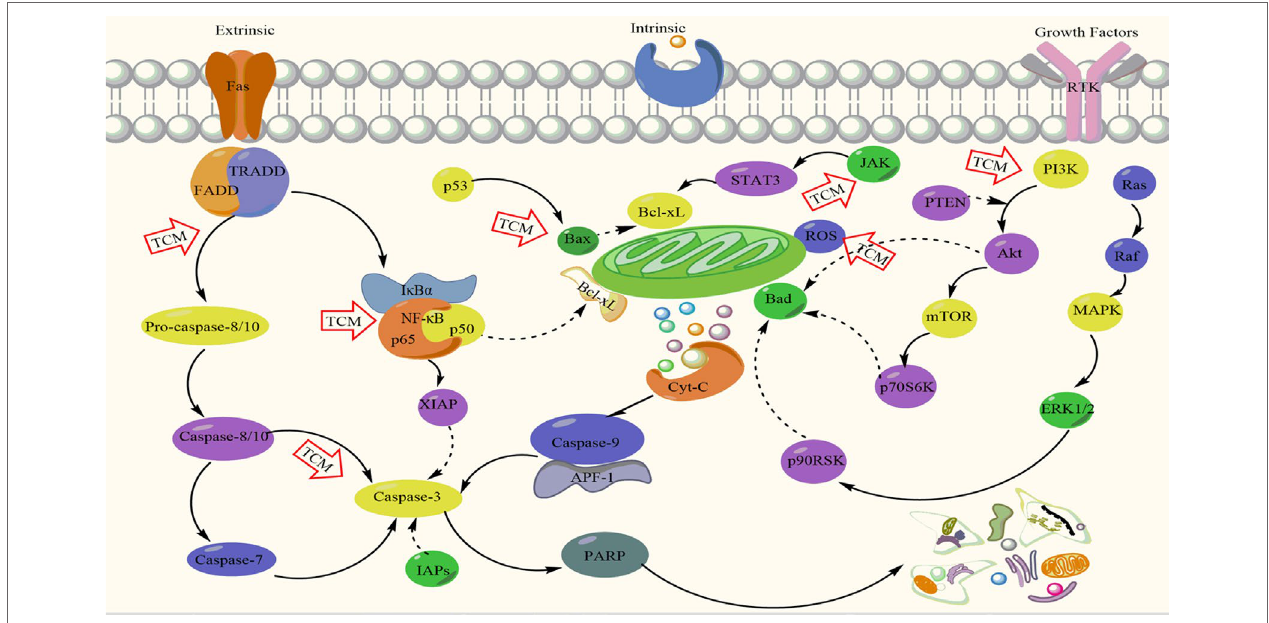
FIGURE 1 | Mechanistic actions of apoptosis induction by traditional Chinese medicines (TCMs). Akt, protein kinase B; APF-1, ATP-dependent proteolysis factor 1; Bax, BCL2-associated X; Bcl, B cell lymphoma; Cyt c, cytochrome c; ERK1/2, extracellular regulated protein kinases; FADD, Fas associated death domain; IAPs, inhibitor of apoptosis proteins; I κ B α , nuclear factor of kappa light polypeptide gene enhancer in B-cells inhibitor, alpha. JAK, Janus kinase; MAPK, mitogen-activated protein kinase; Mcl, myeloid cell leukemia sequence 1; mTOR, mammalian target of rapamycin; NF- κ B, nuclear factor kappa B; PI3K, phosphatidylinositol-3 kinase; PARP, poly ADP-ribose polymerase; PTEN, phosphate and tension homology deleted on chromosome ten; Raf, rapidly accelerated fibrosarcoma; ROS, reactive oxygen species; RTK, receptor tyrosine kinase; STAT3, signal transducer and activator of transcription 3; TRADD, tumor necrosis factor (TNF) receptor associated death domain; XIAP, X-linked inhibitor of apoptosis